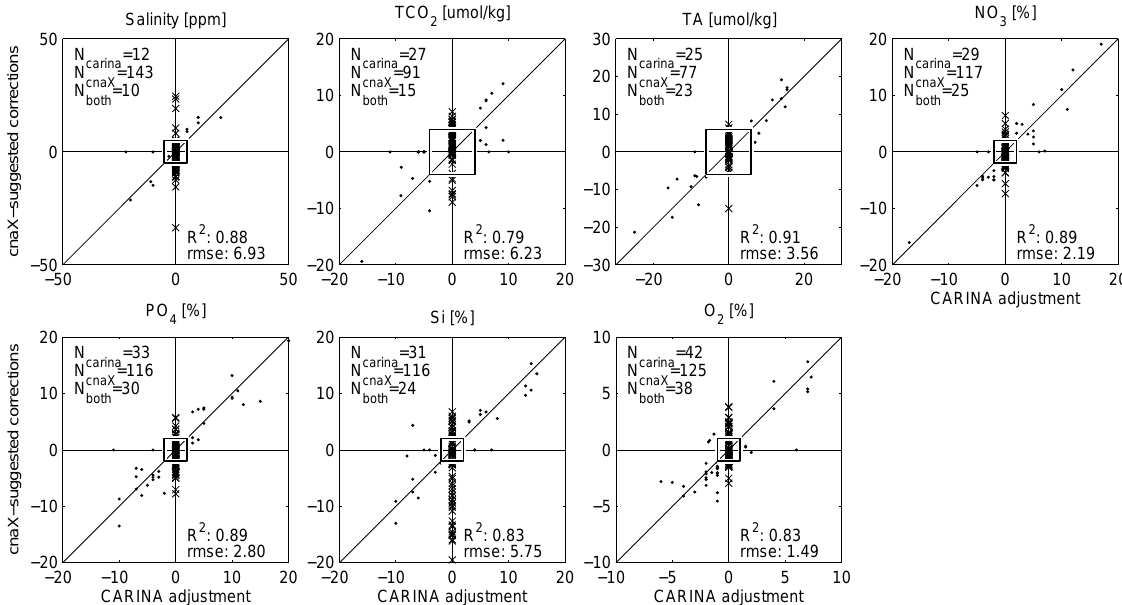
Figure 8. A comparison between the corrections suggested by the cnaX routine and the adjustments applied to the CARINA data product. Black dots denote that an adjustment was applied; black crosses that no adjustment was applied. The square in the middle of the figures indicate the minimum adjustment that were applied to the data. The numbers in the upper left corner states the number of cruises for which a correction was suggested by the cnaX method ( N cnaX ) and the number of adjustments applied to the CARINA data ( N carina ); the numbers in the lower right corner states the R 2 value of the linear fit and and the rmse of the di ff erence between the methods for those cruises where an adjustment was